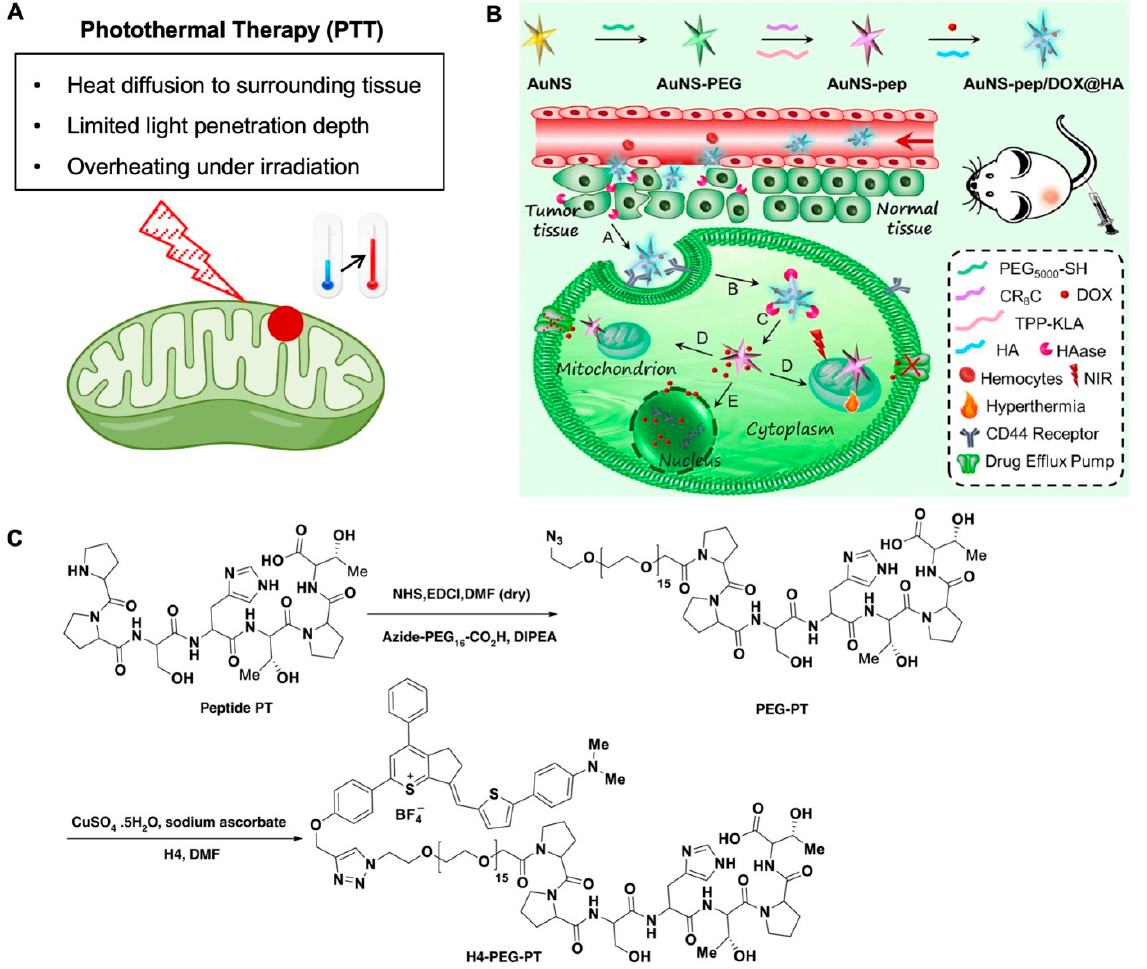
Figure 3. Mitochondria-targeting in photothermal therapy. ( A ) A schematic illustration of mitochondria-targeting photothermal therapy and its major challenges. ( B ) A mitochondria-targeting “Nanoheater”, gold nanostar (AuNS), for enhanced photothermal/chemotherapy [85]. ( C ) Synthesis route of an upconversion NIR-II fluorophore for mitochondria-targeted cancer imaging and photothermal therapy [86]. Reproduced with permission from references [85] (Copyright 2019 by Elsevier) and [86] (Open access article distributed under the terms of the Creative Commons Attribution License) for the images in ( B , C ), respectively.